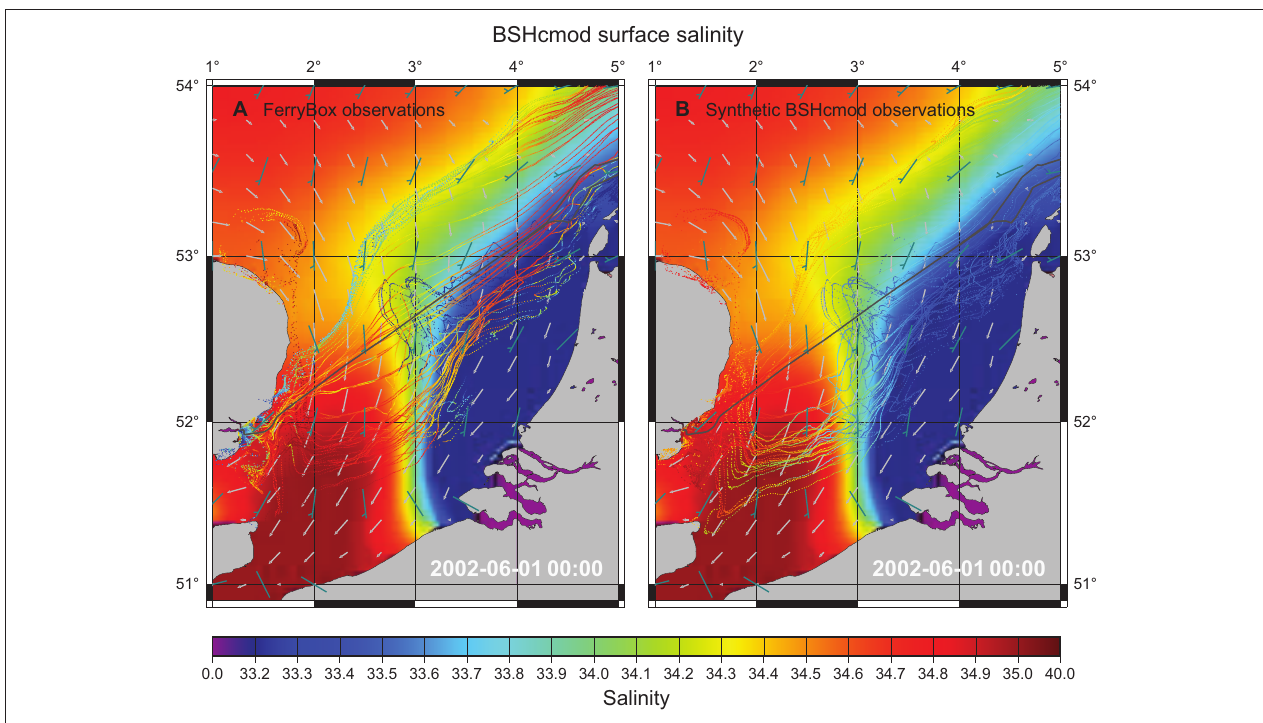
FIGURE 11 | (A) Composite of a surface salinity field from BSHcmod (1 June 0:00) and the corresponding synoptic map derived by combining FerryBox observations within ± 40 days with BSHcmod surface currents (cf. Figure 10B ). (B) The same composite but replacing real FerryBox salinity observations by their simulated counterparts (same location and time) from